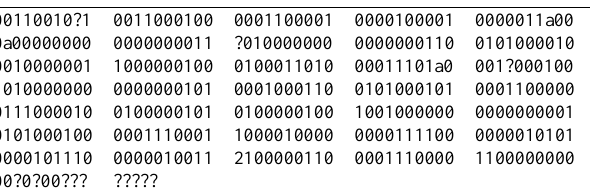
Table 1. Character states of Moenkhausia doceana . Character list is the same of Mirande (2010); polymorphisms [01] are represented as